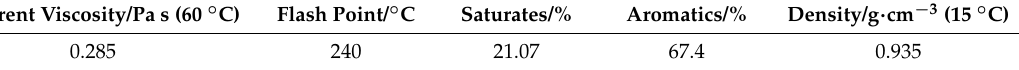
Table 2. Properties of the rejuvenator.